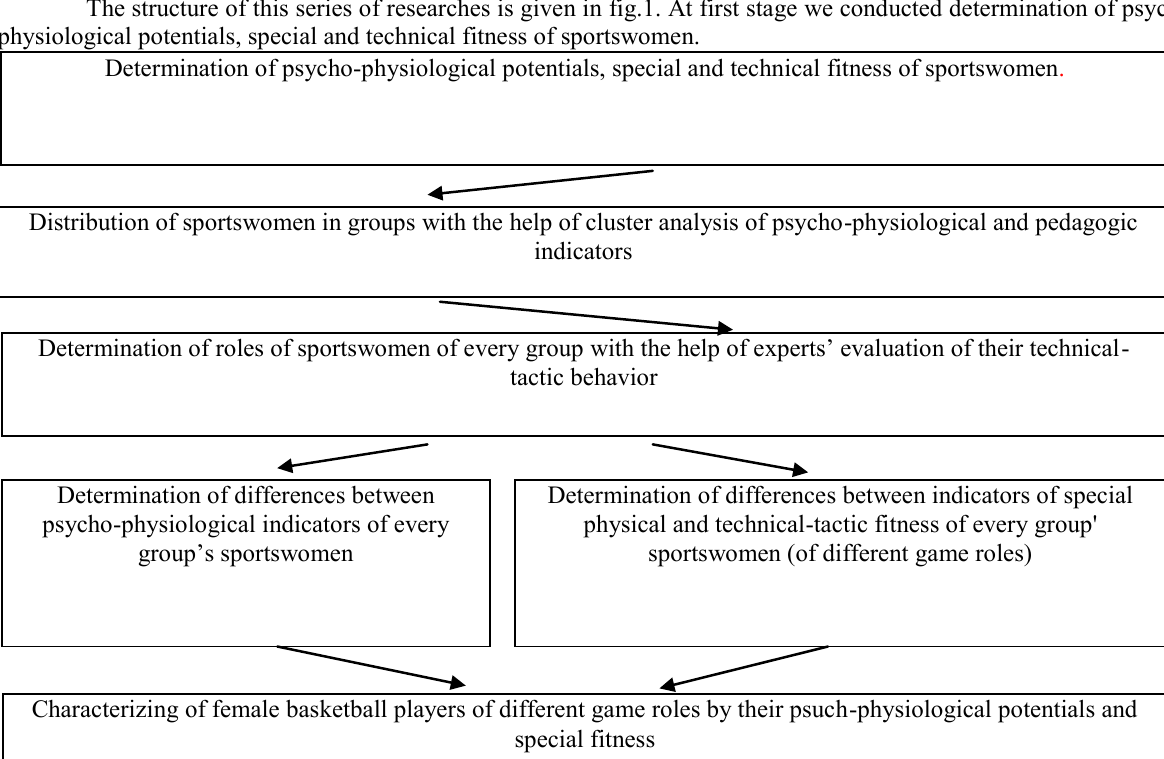
Fig.1. Schema of experimental researches for specifying of basketball players’ game functions and formation of tactic